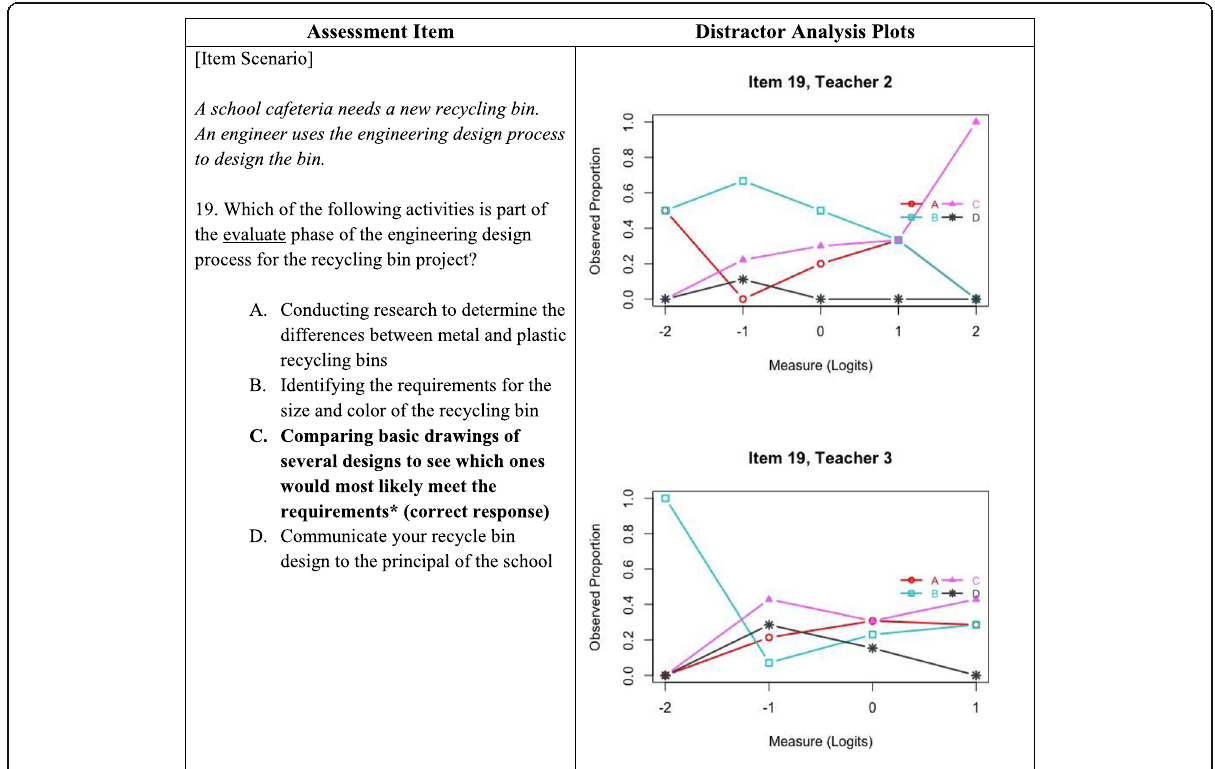
Fig. 9 Distractor analysis plot for item 19: teacher 2 and teacher 3. The plots in this figure show patterns of student answer choices for item 19 in teacher 2 ’ s classroom (top plot) and in teacher 3 ’ s classroom (bottom plot). In both plots, the x -axis displays estimates of student achievement. Student achievement estimates are shown in logits, and these estimates were calculated using the Rasch model. Low values indicate lower achievement, and high values indicate higher achievement. The y -axes shows the observed proportion of responses for a given answer choice. The lines in each plot show the proportion of students who selected each of the four answer choices (A, B, C, or D) at each level of achievement. For this item, the correct response is C (pink line with triangle plotting